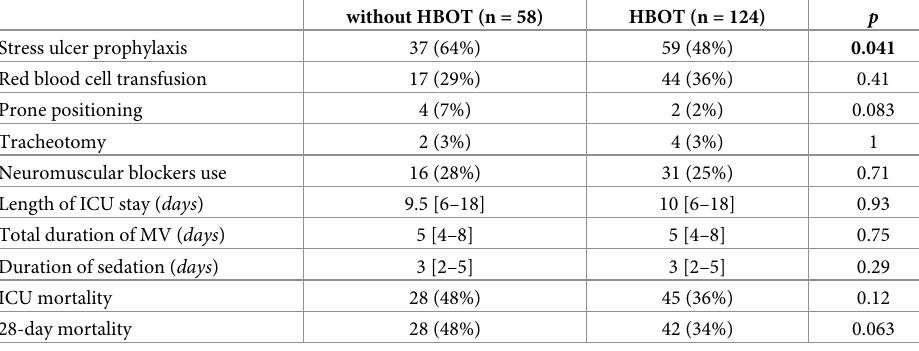
Table 4. Patient data during ICU stay without / with